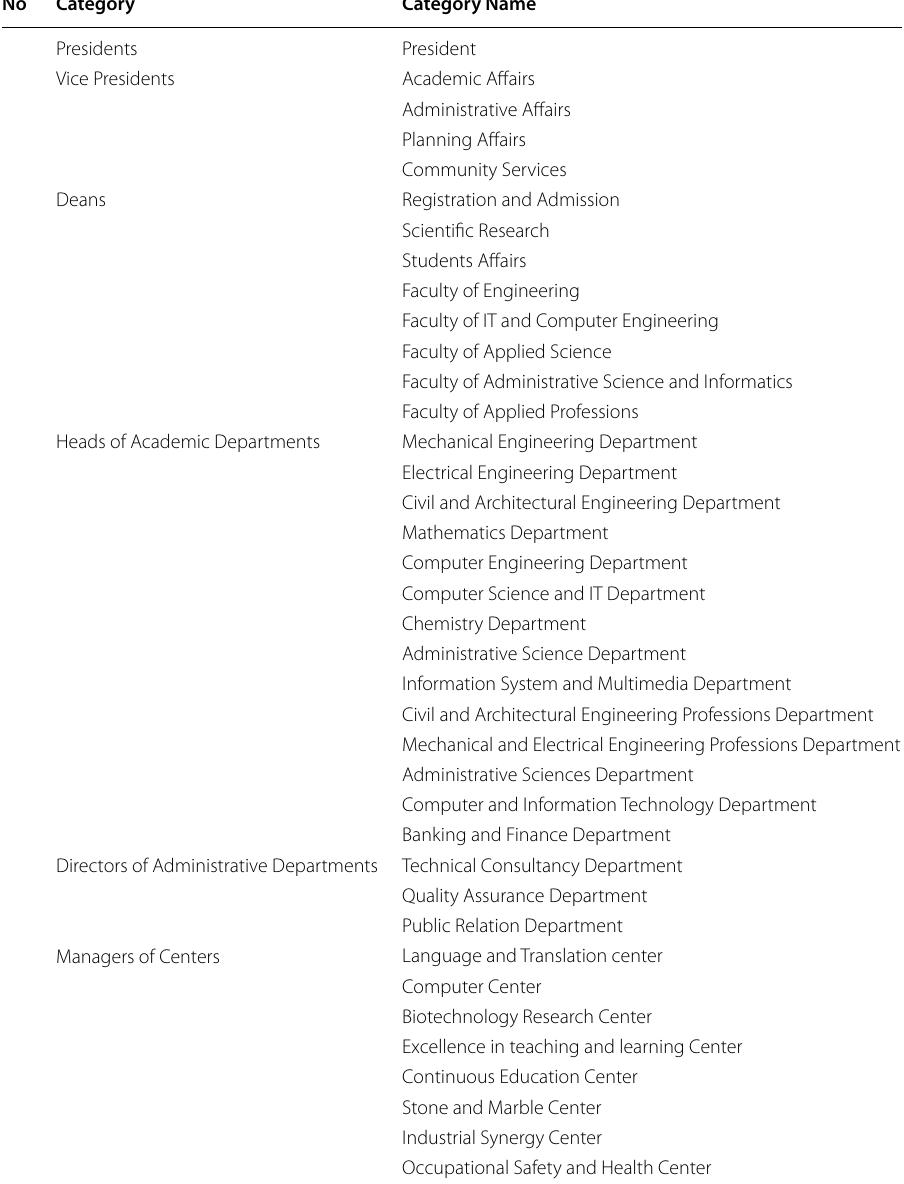
Table 1 List of targeted departments and centers of the study population No